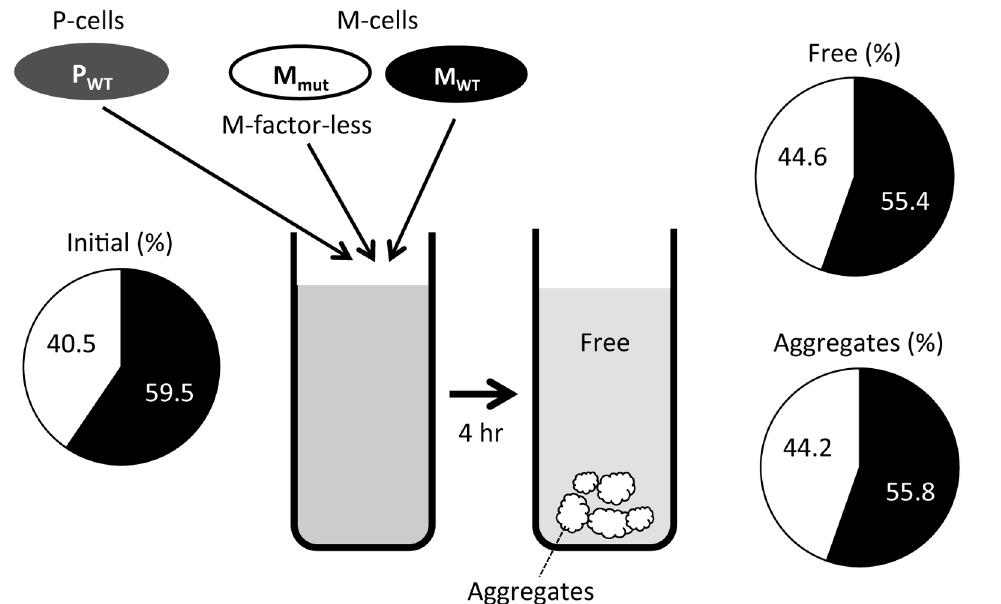
Figure 5. M-factor-less cells are incorporated in cell aggregates during co-cultivation with wild-type M-cells. Wild-type P- cells (FS127), wild-type M-cells (L972) and M-factor-less M-cells (FS120) were mixed in SSL−N in the cell number ratio of 2:1:1. FS127 carries a uracil-auxotrophic marker ( ura4-D18 ), and FS120 harbors an adenine-auxotrophic marker ( ade6-M210 ). After 4 hr of culture with shaking, cell aggregates were obtained after the culture was allowed to stand for a few minutes. Cells were sampled from the precipitated aggregates and the floating fractions separately. The fractions were briefly sonicated to disperse cell clusters, and the cells were spread on SD without leucine but with one-quarter strength adenine-sulfate. P-cells could not form colonies because of uracil depletion. M-cells derived from the M-factor-less strain formed red colonies due to ade6-M210 , and those from the wild-type strain formed white